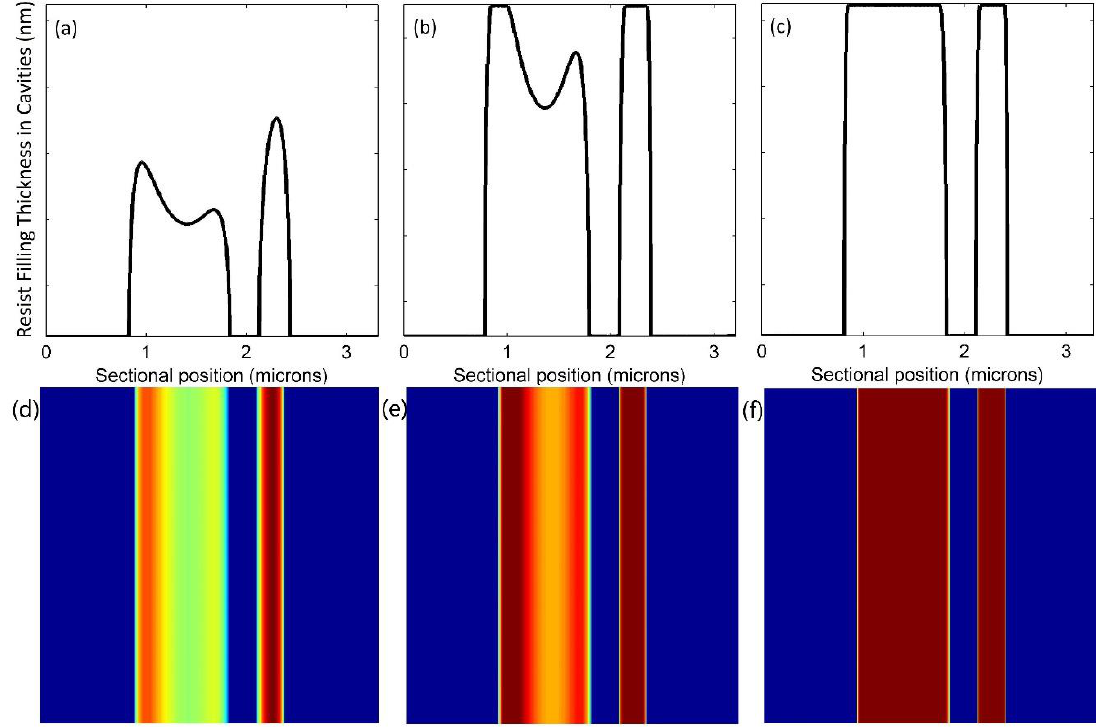
Figure 5. Profiles of resist filling in the nanoscale cavity at ( a ) 1.08 s; ( b ) 4.32 s; ( c ) 10.80 s and their corresponding top views at ( d ) 1.08 s; ( e ) 4.32 s; ( f ) 10.80 s.